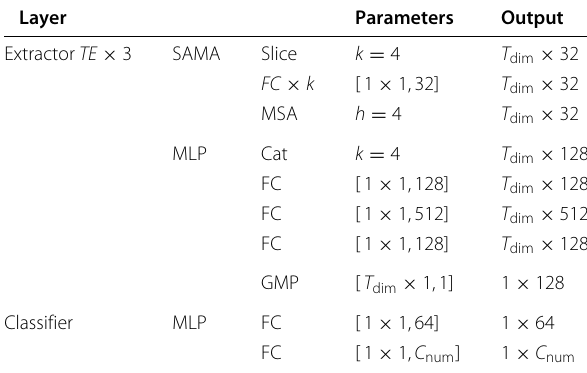
of multi-head self-attention. Figure 5 illustrates when k equals h , and The calculation is formulated in Eqs. (5) and